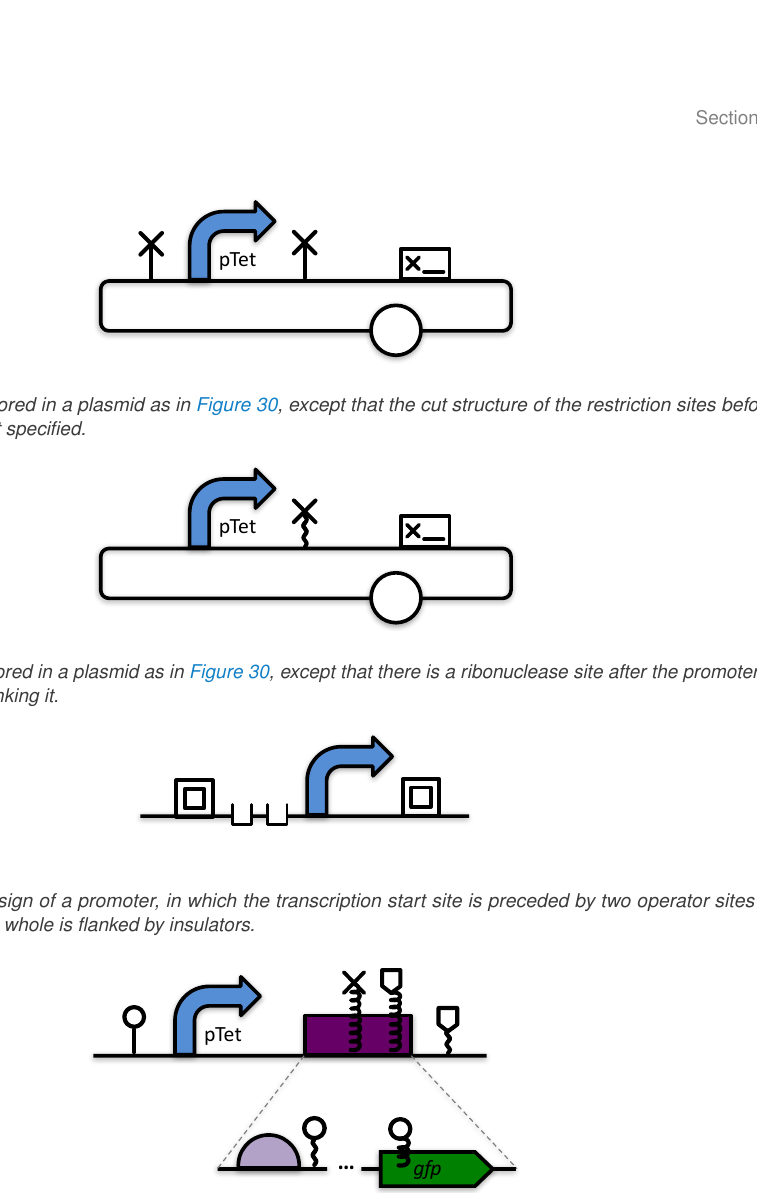
Figure 35: Promoter regulating the production of an engineered composite sequence that includes RNA and protein stability elements at its 3’ end, as well as an internal site for protease cleavage, as well as the expansion of the composite to show it contains a ribosome entry site. coding sequence, and other omitted details. Single residue locations of interest are indicated for the DNA (before the promoter), RNA (after the ribosome entry site), and protein (in the CDS).